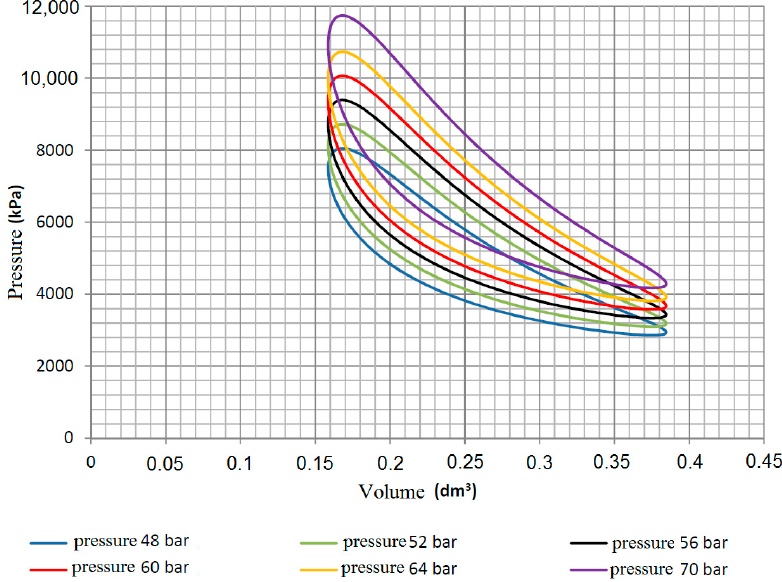
Figure 9. P-V diagram for different mean working pressure.